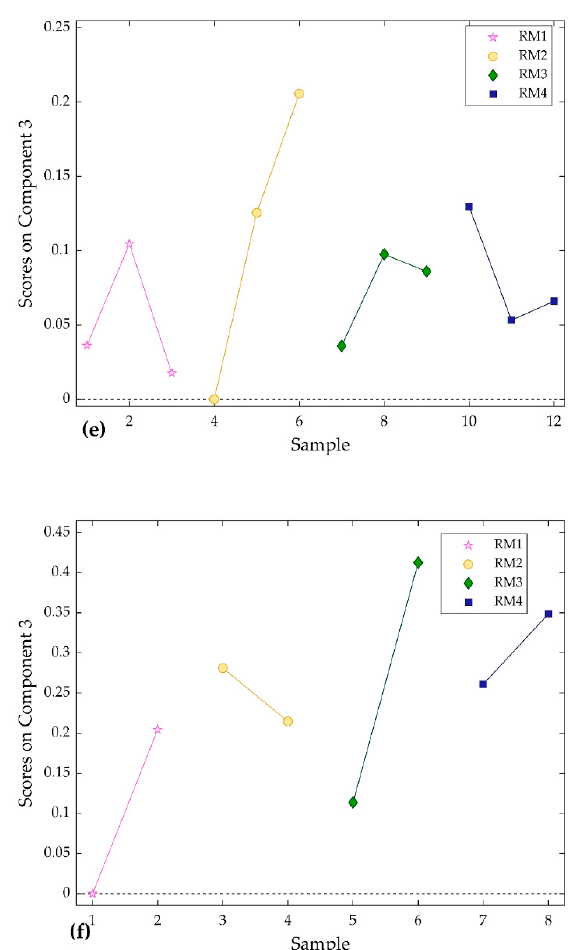
Figure 9. Scores of the two PARAFAC models with three components. (a ) Scores of component 1 (TGIS), ( b ) scores of component 1 (TGO), ( c ) scores of component 2 (TGIS), ( d ) scores of component 2 (TGO), ( e ) scores of component 3 (TGIS), and ( f ) scores of component 3 (TGO). Quantity estimation: following assessment of the score values, the component which showed increased score with increased RM were analyzed by PLS linear regression. Unknown quantity of component 1 was predicted for each sample (Figure 10) using score values of the component from PARAFAC models and measured values of RM (Table 1). The regression analysis showed R 2 = 0.92 and 0.98, and RMSECV (Equation (2)) = 0.36 and 0.22 mg for TGIS and TGO respectively (Figure 10a,b).